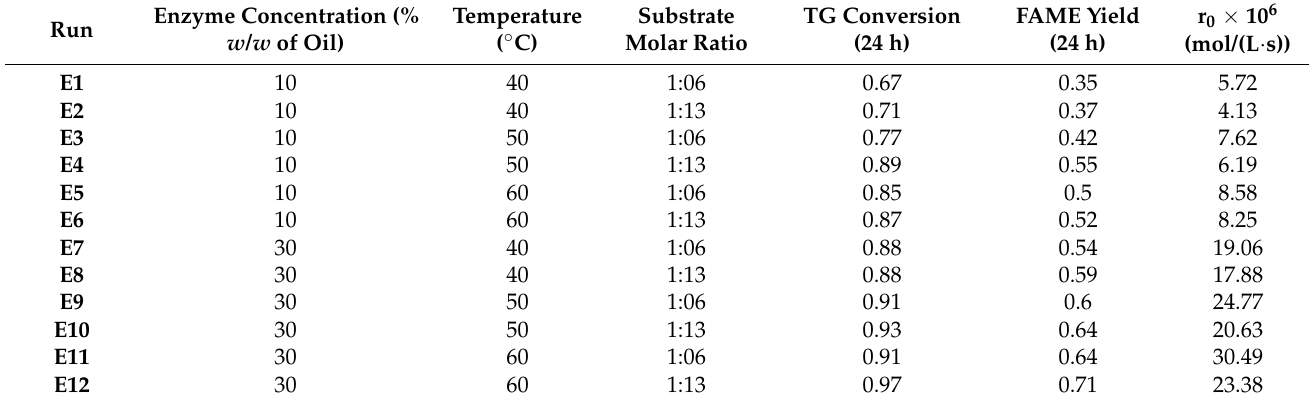
Table 1. Experimental runs of the interesterification of methyl acetate with castor oil: conditions